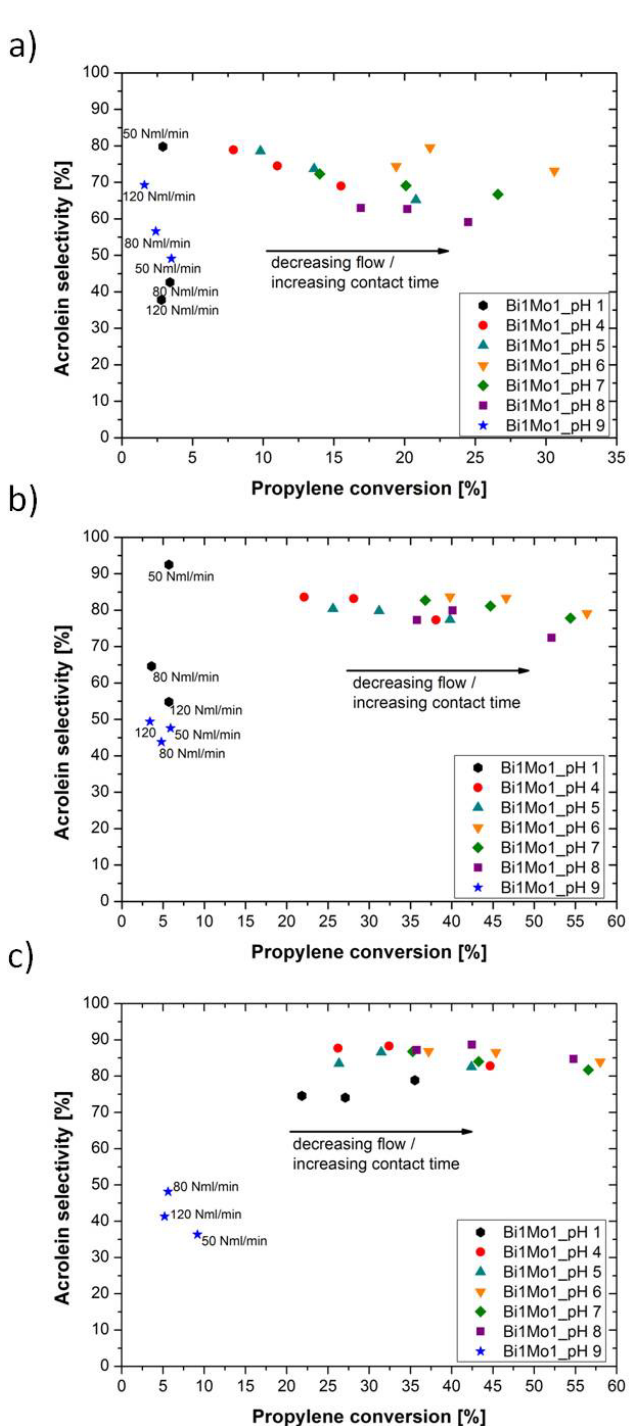
Figure 3. Catalytic performance of samples prepared with Bi/Mo = 1/1 at 320 °C ( a ); 360 °C ( b ) and 400 °C ( c ). The samples were dried in air at room temperature, crushed, sieved and pre-treated in the reactor in synthetic air at 300 °C. Reaction conditions: 500 mg catalyst; C 3 H 6 /O 2 /N 2 = 5/25/70; 50, 80 and 120